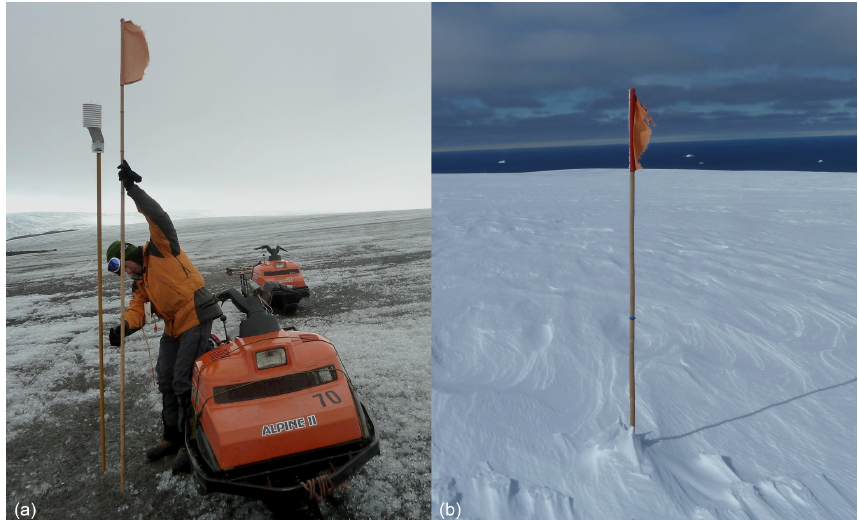
Figure 5. MBS transects installed on the Fourcade Glacier during the ablation period on 28 March 2012 (a) and during the accumulation period on 10 November 2012 (b) .